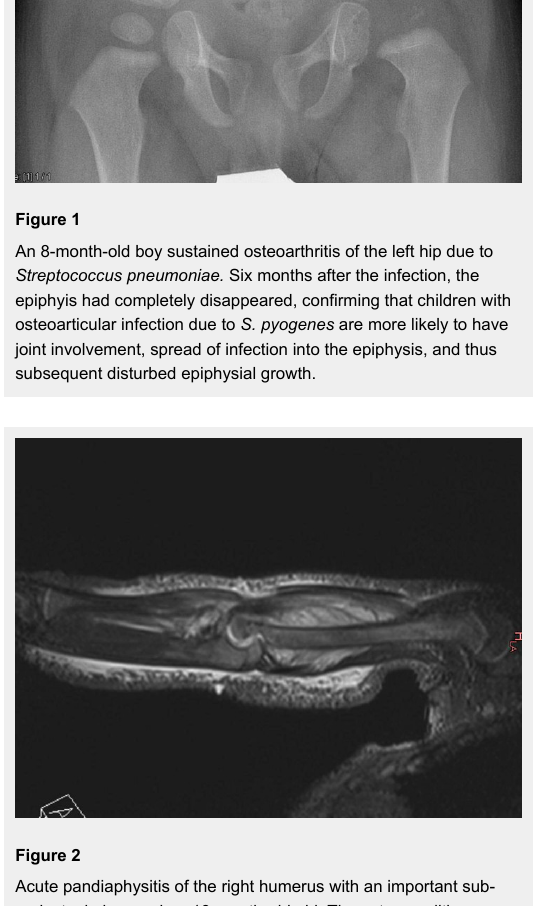
Acute pandiaphysitis of the right humerus with an important sub- periosteal abscess in a 16-month-old girl. The osteomyelitis was due to Haemophilus influenzae type B despite the child being completely